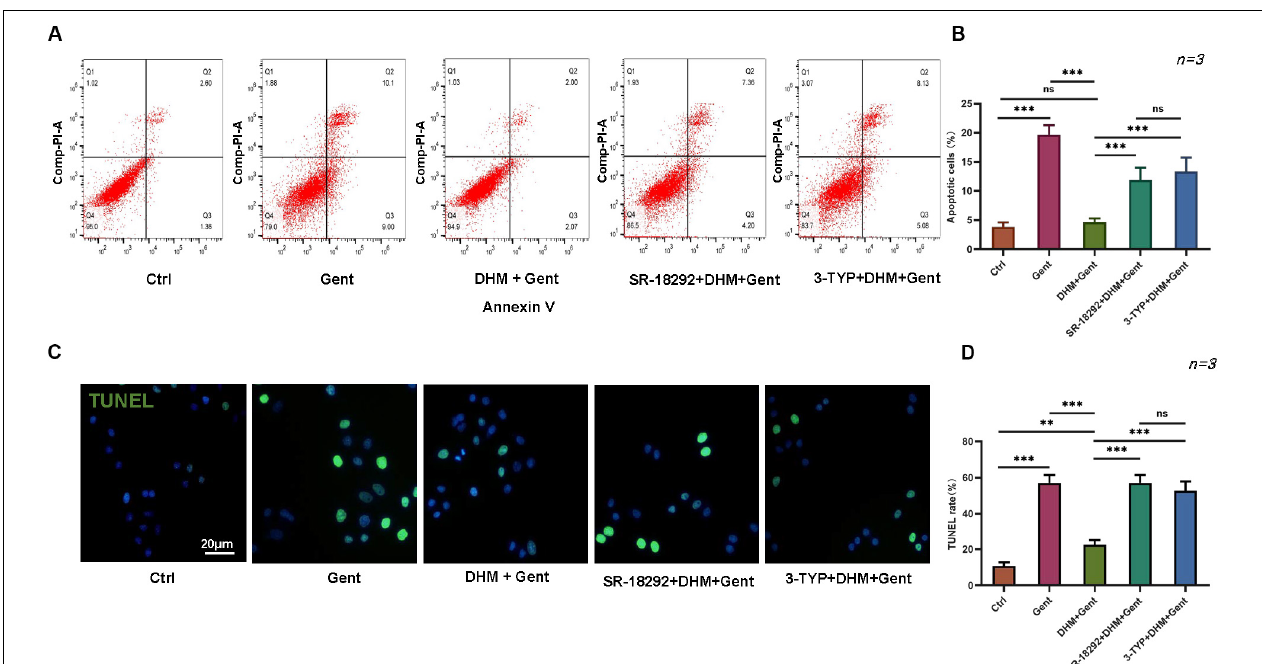
FIGURE 5 | PGC-1 α and SIRT3 mediate the protective effect of DHM against gentamicin-induced HEI-OC1 cell apoptosis. (A,B) Flow cytometry detection of apoptosis in HEI-OC1 cells treated with PGC-1 α and SIRT3 inhibitors (SR-18292 and 3-TYP, respectively) prior to DHM and gentamicin treatment. (C,D) Quantitative analysis of TUNEL-positive cells following pretreatment with 20 µ M SR-18292 and 50 µ M 3-TYP for 2 h prior to 1 mM DHM treatment and gentamicin exposure. Experiments were repeated three times. NS, not significant; ∗∗ P < 0.01, ∗∗∗ P < 0.001 (one-way analysis of variance followed by Tukey’s multiple comparisons test).